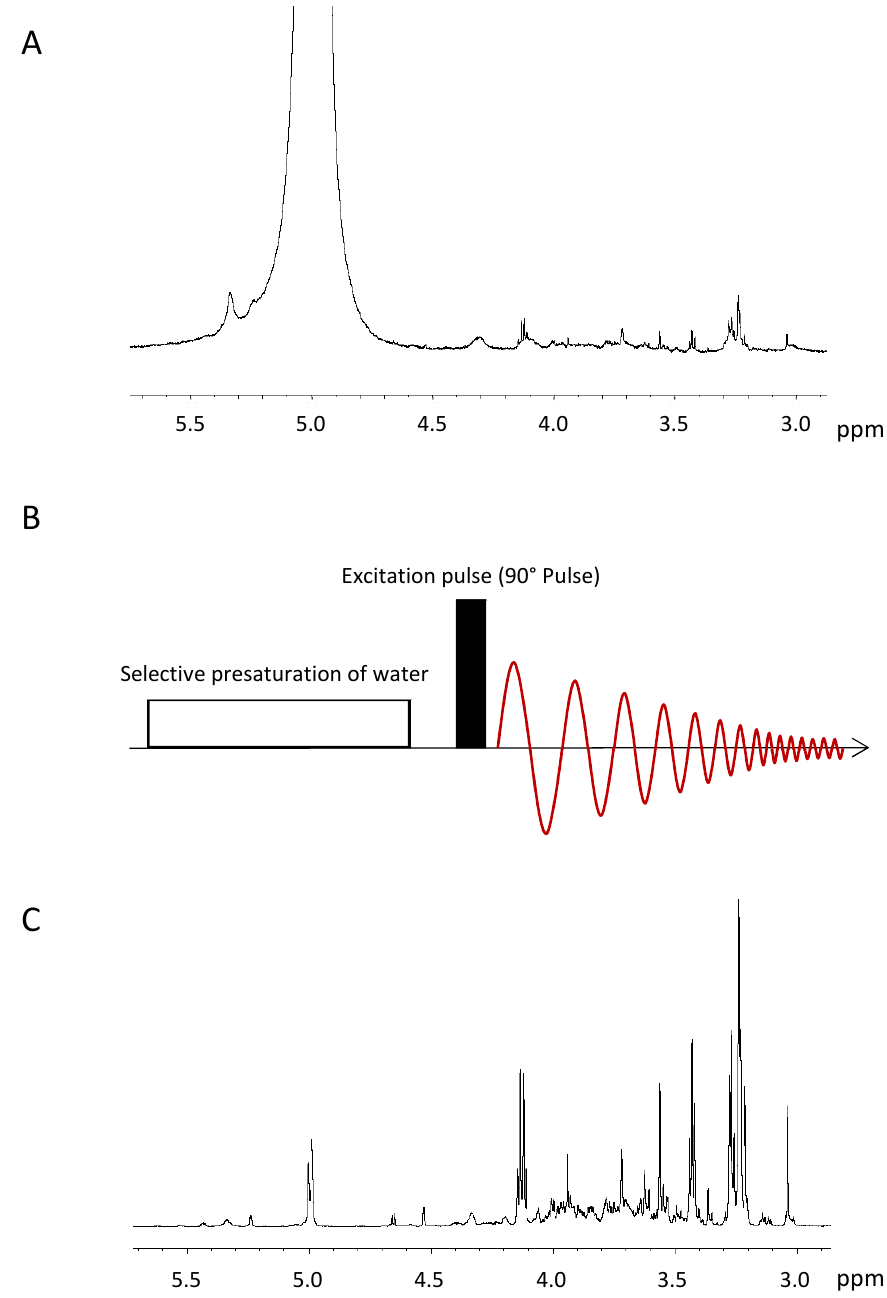
Figure 3. (A) 1 H NMR spectrum of a tumour sample without water suppression. The strong water signal (0 ppm) saturates the analogue to digital converter and leaves just a few bits for the metabolite signals, which impedes the quantification of the latter. (B) Schematic representation of the presaturation the sample and data acquisition. (C) 1 H NMR spectrum of a breast cancer specimen with an